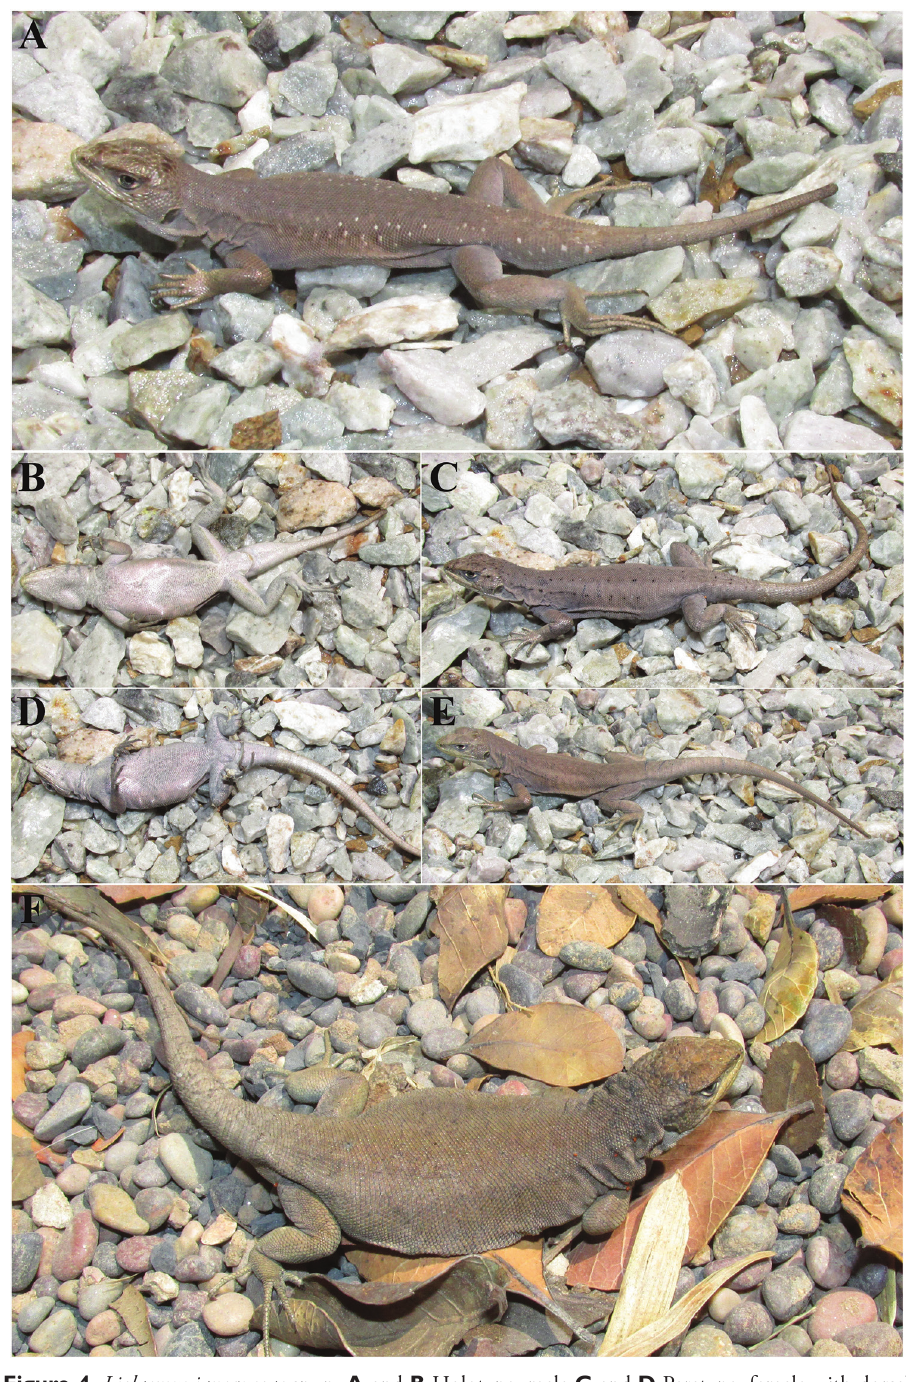
Figure 4. Liolaemus janequeoae sp. n. A and B Holotype, male C and D Paratype, female with dorsal black dots E and F Paratypes, typical